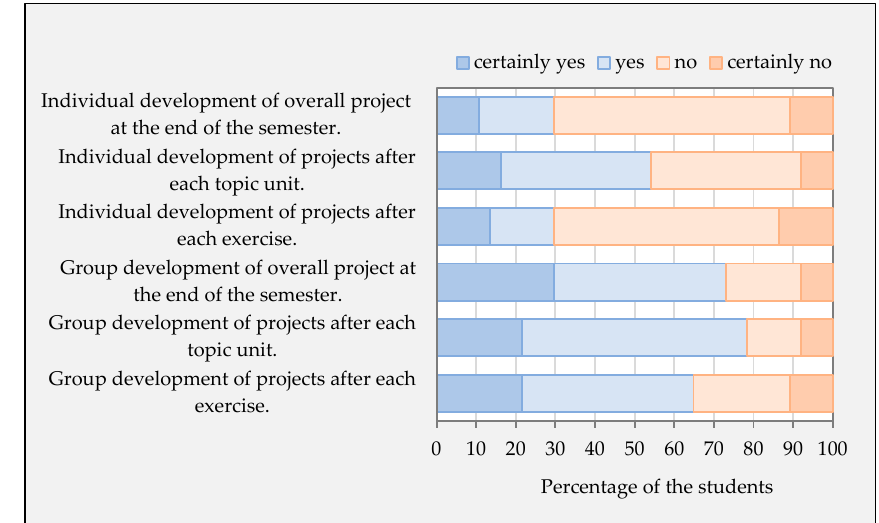
Figure 16. Students’ suggestions for exercise redesign.